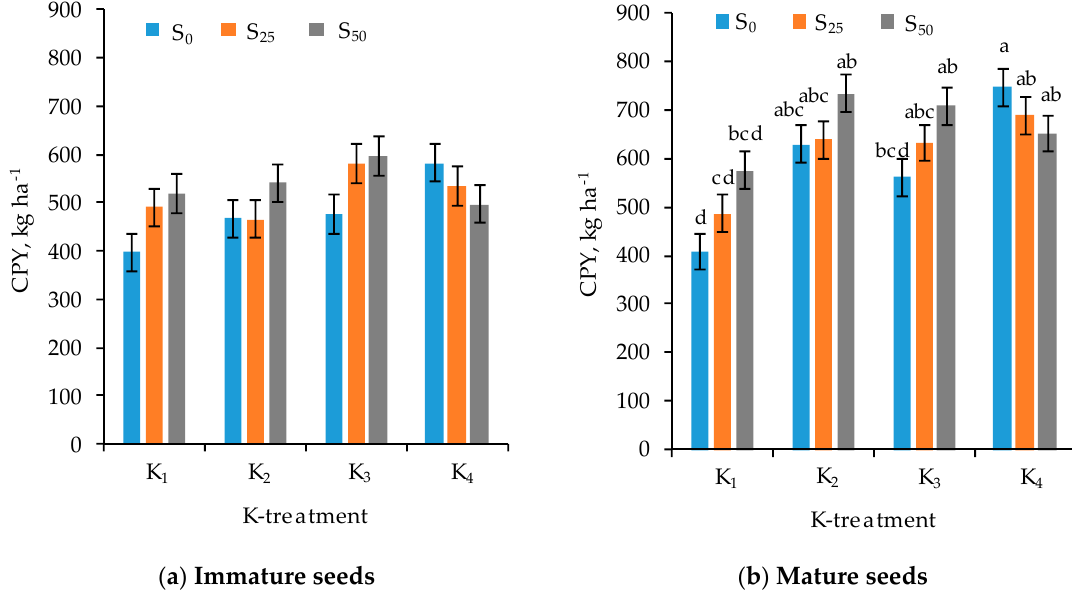
Figure 2. Effect of interaction between K and S application on crude protein yield (CPY) in: ( a ) immature seeds; and ( b ) mature seeds. K 1 , K 2 , K 3 , and K 4 refer to levels of soil K availability and fertilization; S 0 , S 25 , and S 50 refer to sulfur application at rates of 0, 25, and 50 kg S ha − 1 , respectively. Letters indicate significant differences between treatments ( p < 0.05). Hatched bars represent 2 × standard error (SE) ranges. Table 4. Effect of years and K treatments on tannin content (mg kg − 1 ) in immature seeds (GS) and mature seeds (MS) of faba bean.